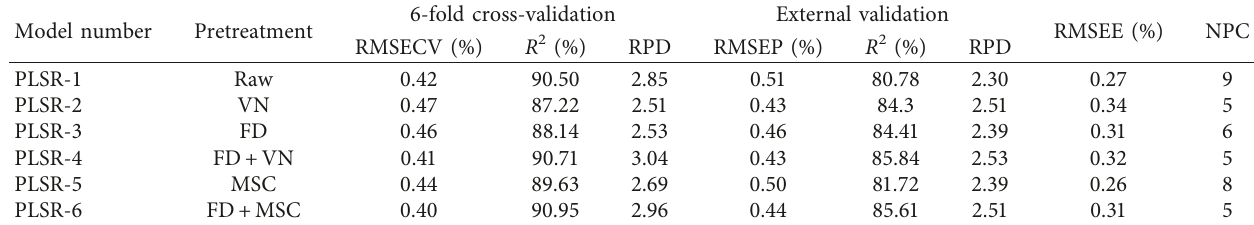
Table 5: Validation and predictive results of PLSR models with different pretreatment